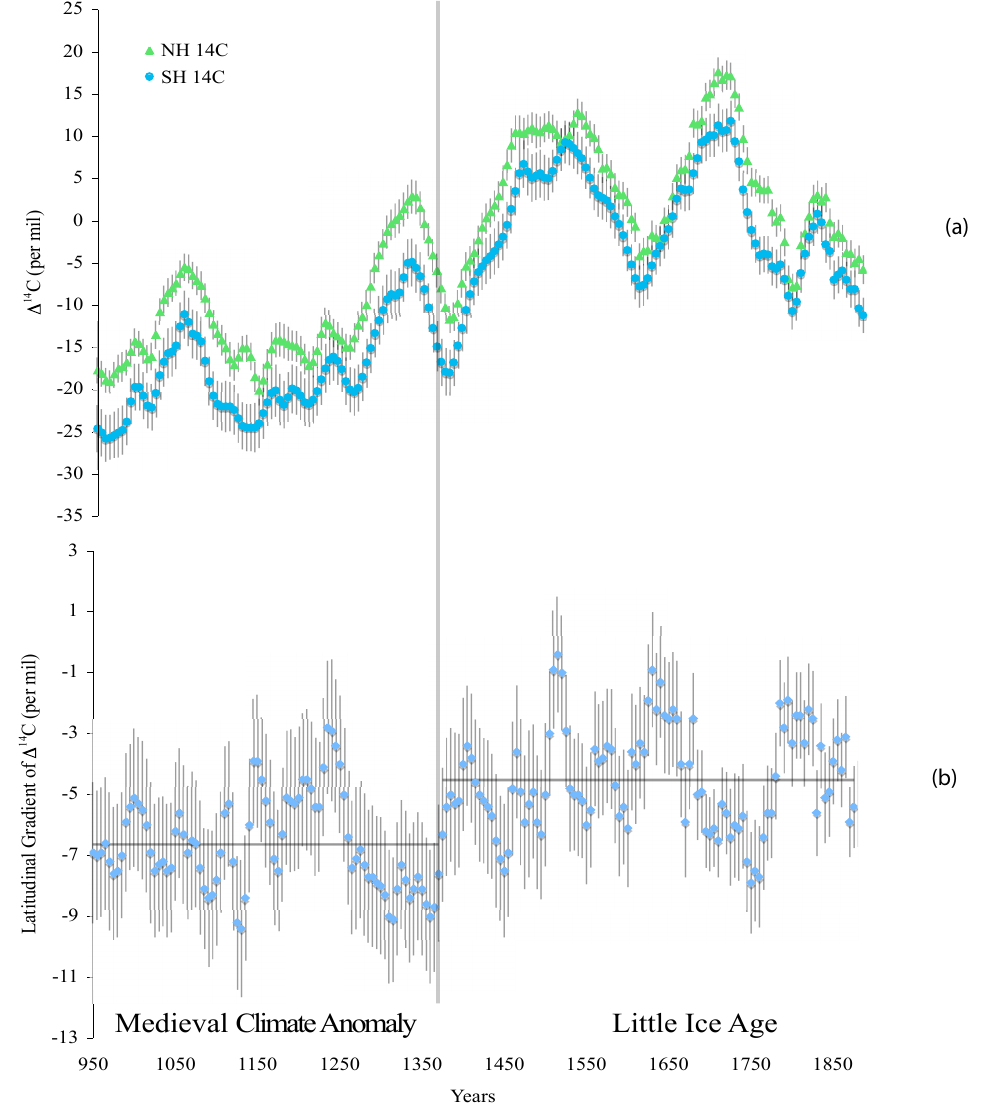
Fig. 1. Tree ring measurements of atmospheric 1 14 C over the period AD 950–1830; (a) the Northern Hemisphere INTCAL04 record (Reimer et al., 2004) is shown as triangles, the Southern Hemisphere SHCAL04 (McCormac et al., 2004) record as circles. The temporal resolution of each record is five years. The uncertainties shown in the panel reflect the uncertainties as given in the INTCAL04 and SHCAL04 datasets themselves. (b) The Interhemispheric Gradient in atmospheric 1 14 C, again with five-year resolution. This is obtained by subtracting the INTCAL04 time series from the SHCAL04 time series. The uncertainties in this difference plot are calculated as the square root of the sum of the squares of the